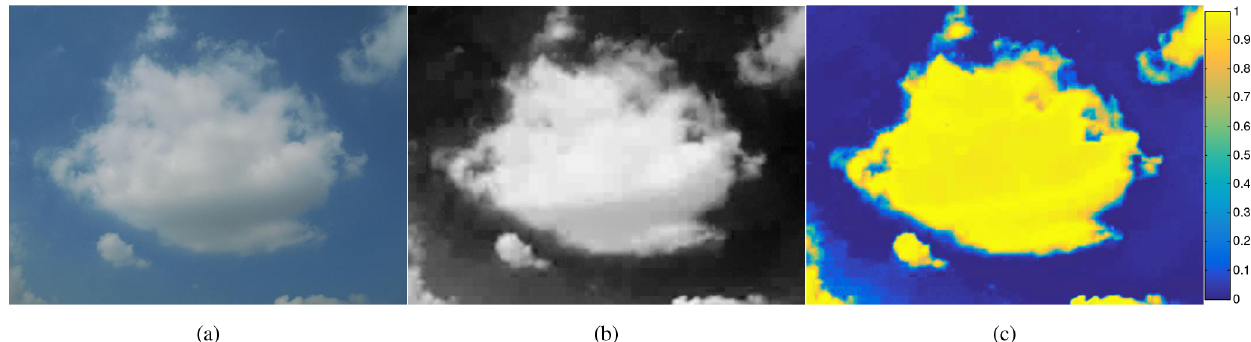
Figure 3. Illustrative example to demonstrate the probability of a pixel belonging to the “cloud” category. (a) Sample sky–cloud image. (b) Normalized (B − R) / (B + R) color channel image. (c) Probabilistic output image using the method from Dev et al.